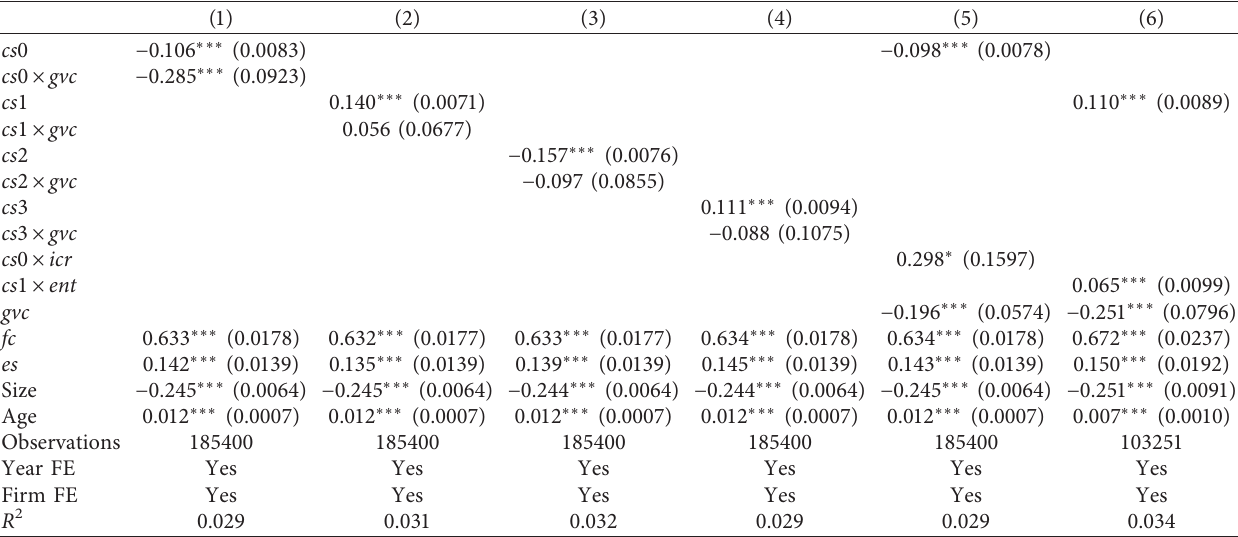
Table 9: The estimate results of regressions introducing interact